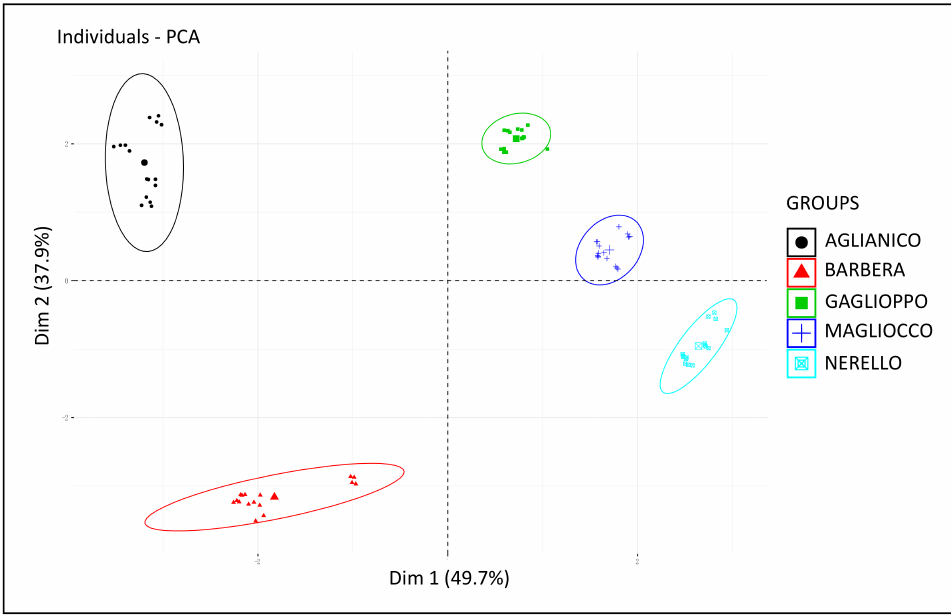
Figure 4. PCA score plot of the first two PCs of whole phenolics and chromatic characteristics data set. Anthocyanin-poor wines (Gaglioppo, Magliocco, and Nerello) turned out to be clus- tered on the same side of the plot and they were differentiated by the variables VRF, BSA reactive tannins, total polyphenols, and acetaldehyde. In turn, Barbera and Aglianico occurred on opposite sides with respect to dimension 2 (characterized by parameters such as SPP, total anthocyanins, monomeric anthocyanins, CI, and Abs 520). It is interesting to observe that Gaglioppo and Magliocco wines showed a lower variability before and